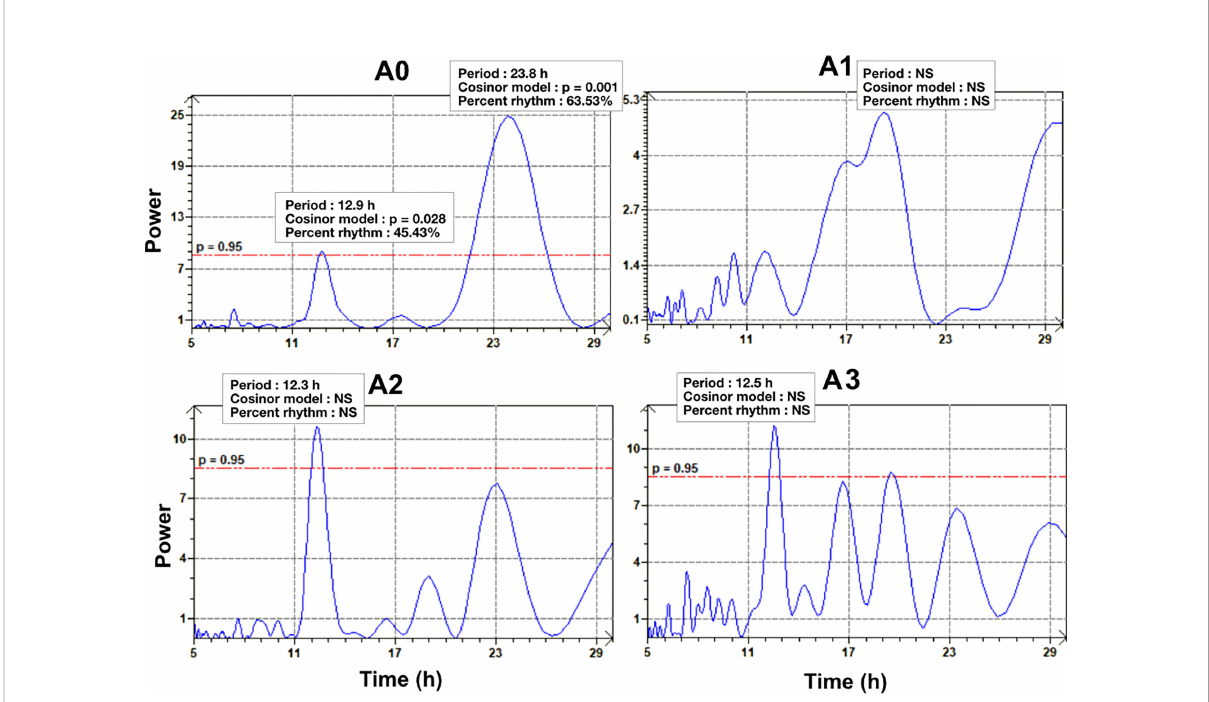
FIGURE 7 Lomb and Scargle periodograms done on VOA data during the time windows of the fi g 5c. A0: 3.72 µg STXeq 100g -1 , A1: 49 µg STXeq 100g -1 (SE = 4.1), A2: 72.16 µg STXeq 100g -1 (SE = 3.8), A3: 104.48 µg STXeq 100g -1 (SE = 3.72). The red line represents the signi fi cancy threshold (p =